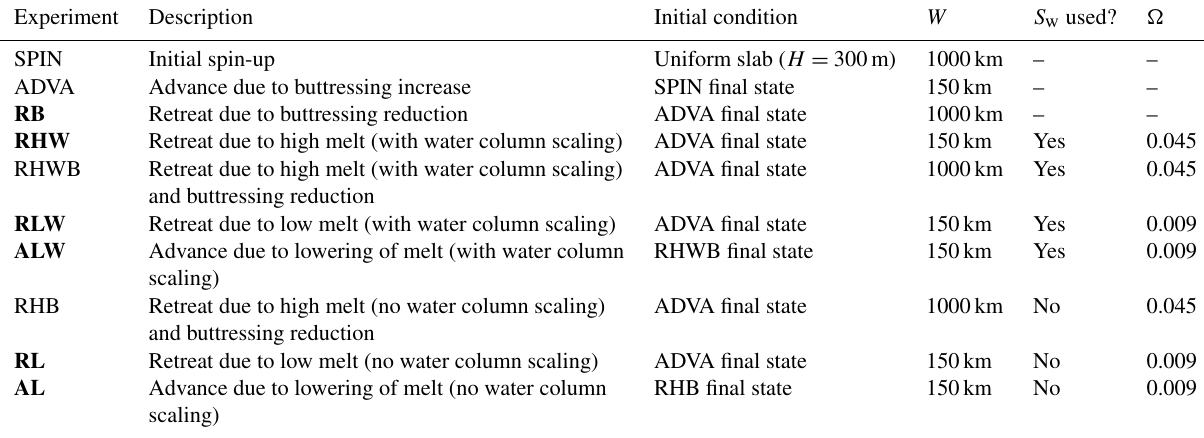
Table 3. Summary of experiments. The experiment name is given in bold for experiments whose results are analysed in the current study. Experiments not given in bold provide spin-up/initialisation for those analysed. The basal melt forcing is described in Sect. 2.2 and the experimental design in Sect. 2.3. W is parameterised channel width, S w is the water column thickness scaling of basal melt (Eq. 8), and (cid:127) is a basal melt tuning